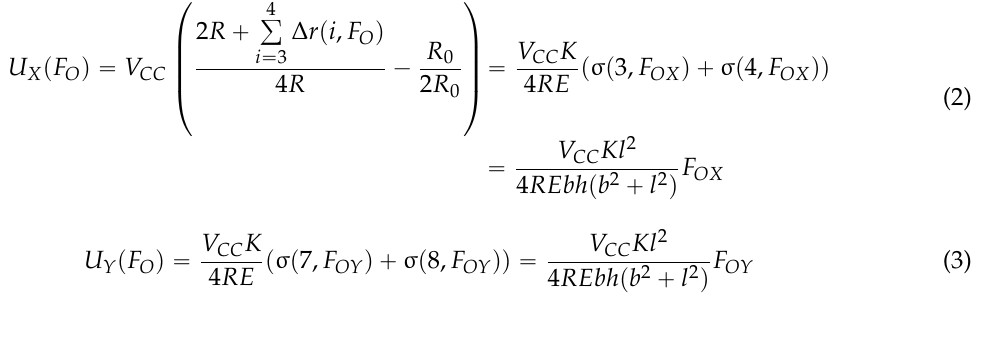
Figure 3. ( a ) Sensitive areas in a cross beam sensor; ( b ) Wheatstone half bridge circuit—Circuit X; ( c ) Wheatstone half bridge circuit—Circuit Y; ( d ) Wheatstone half bridge circuit—Circuit Z. Three Wheatstone half bridge circuits (Circuit X, Y, and Z) are established for the cross beam sensor, as presented in Figure 3b–d. The fixed resistor used in the bridge arms is marked as R 0 , and the same resistance value of strain gauges is written as R . The output signals of the three measuring circuits under F O are given